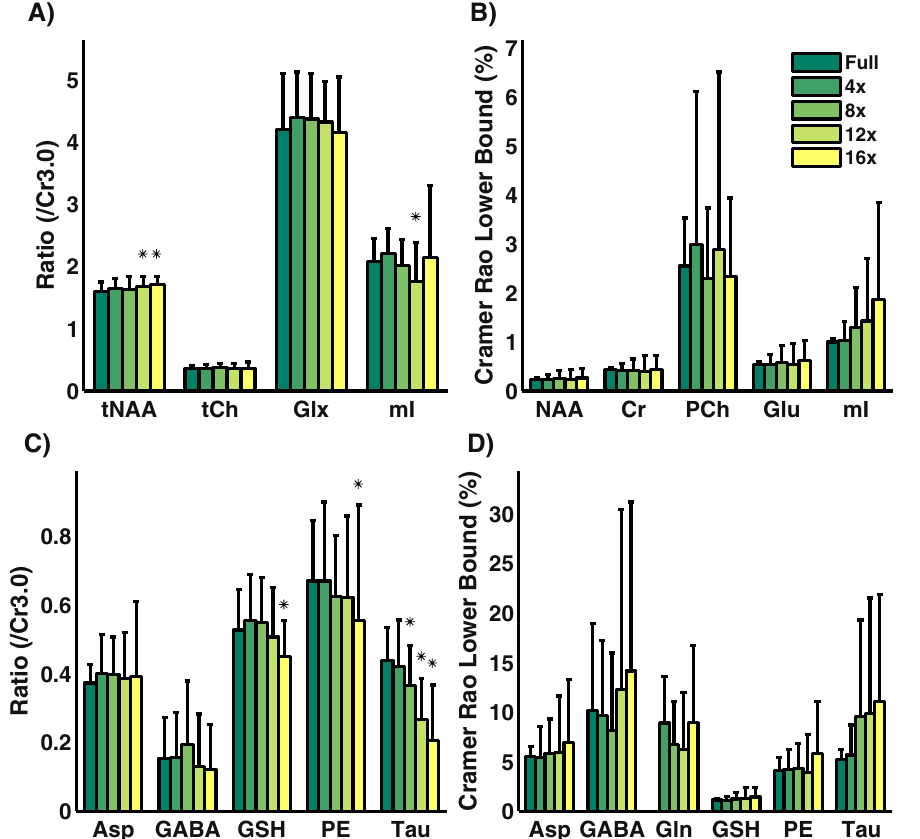
Figure 6. Seventy-two voxels (n = 72) acquired over nine phantom measurements were quantified using ProFit. Phantom measurements were retrospectively undersampled to achieve four acceleration factors (4x, 8x, 12x, and 16x) and were reconstructed before quantitation. Metabolite ratios with respect to Cr3.0 ( A and C ) and Cramér Rao Lower Bound values ( B and D ) are shown. For metabolite ratios, an asterisk denotes a significant difference (p < 0.05) between the accelerated and the fully sampled results using a student’s t-test. With the exception of Tau, most of the significant differences appear after 8x